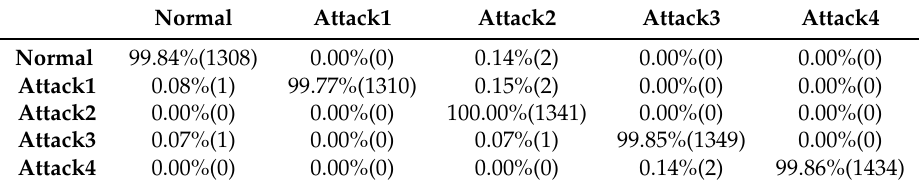
Table 1. The confusion matrix for the multiclass